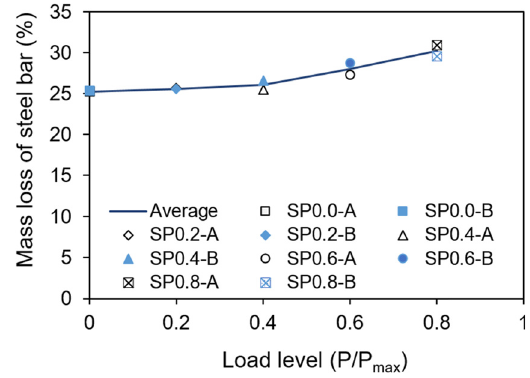
Figure 11: Determination of the mass of corroded steel bars.